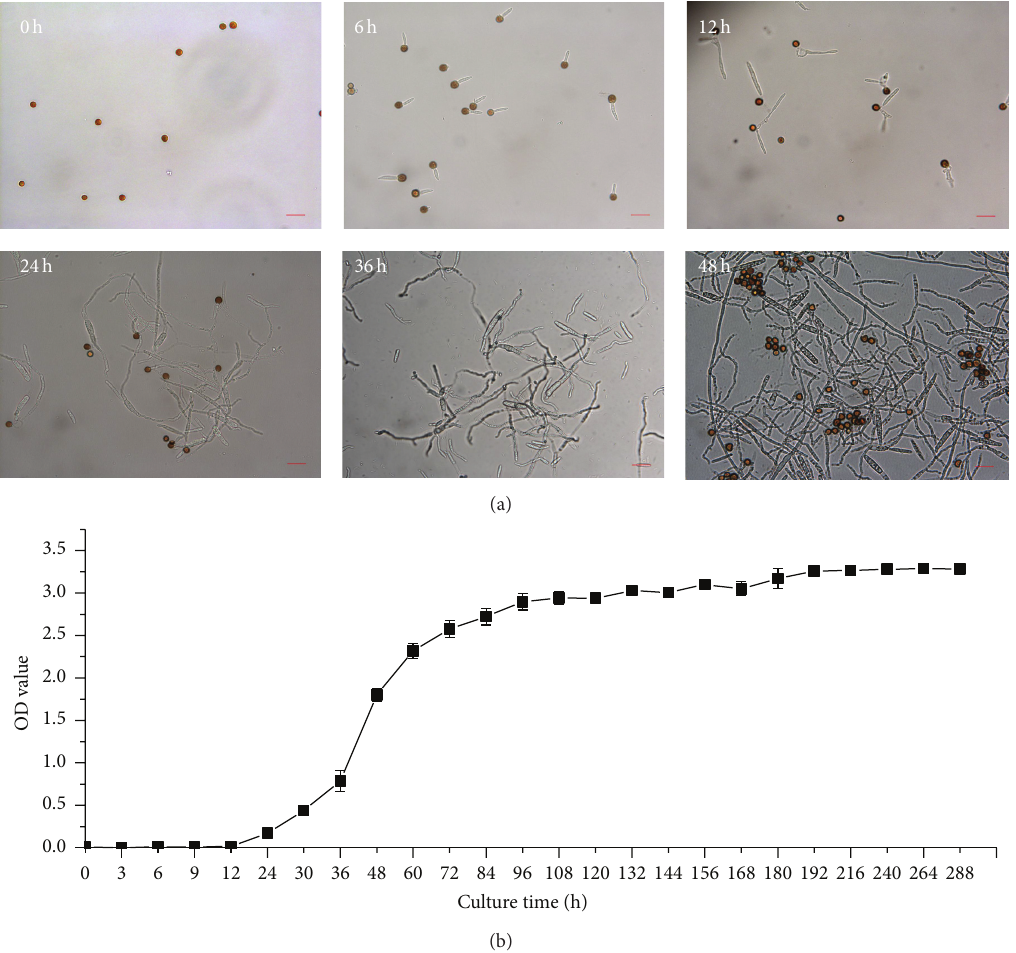
Figure 4: Germination (a) and growth curve (b) of smut teliospores. (a) Teliospore germination monitored by microscopy (magnification × 400), Bar = 20 𝜇 m. (b) The growth curve during the culture process (from 0h to 288 h); all data points mean ± SE ( 𝑛 = 3